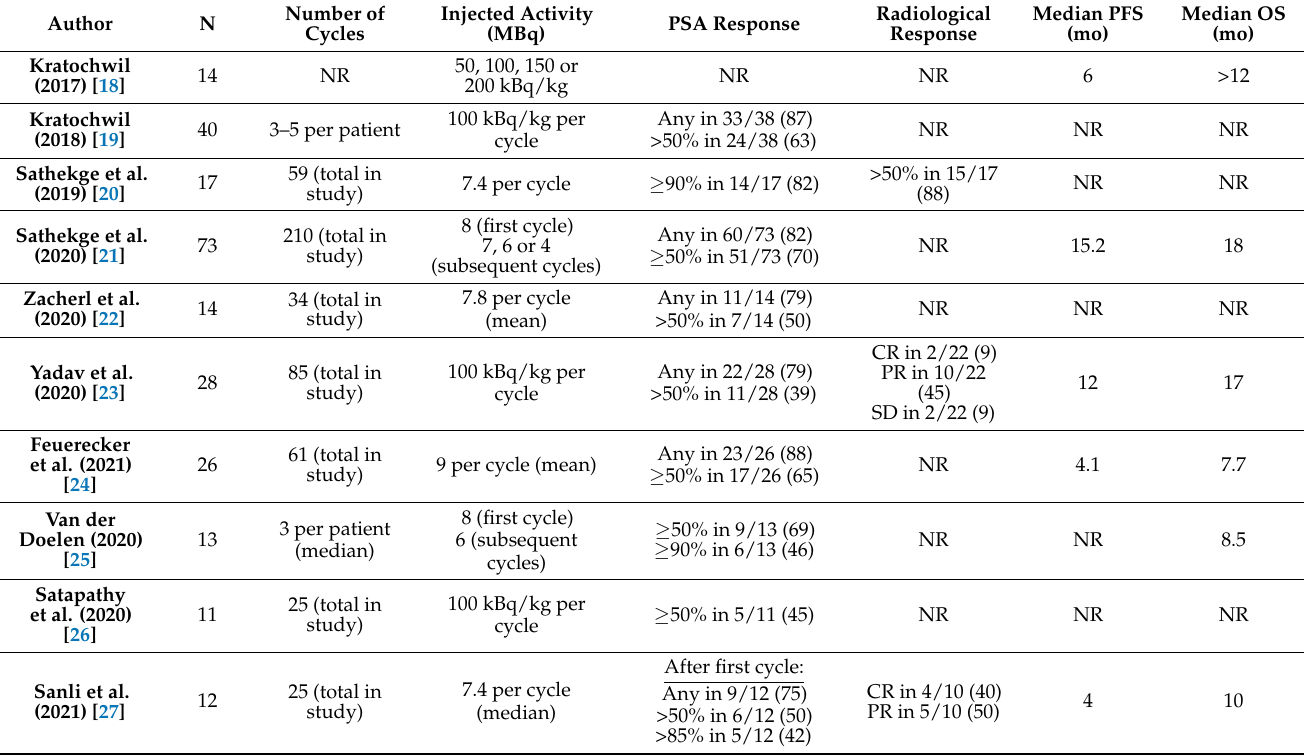
Table 3. Summary of 225 Ac-PSMA